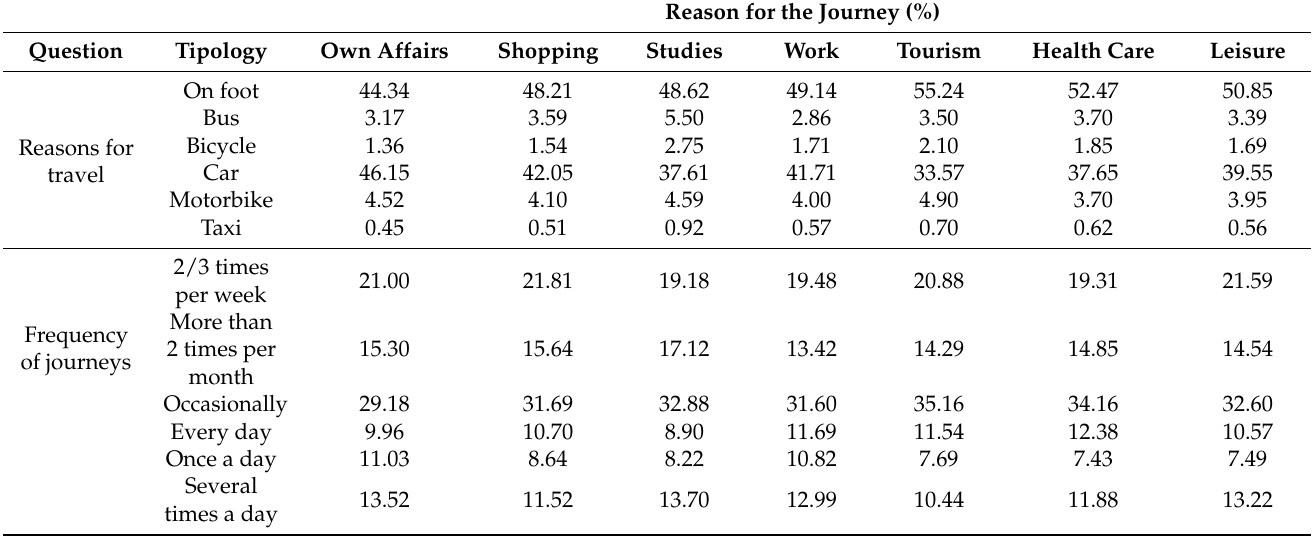
Table 3. Means of transport and frequency of travel by purpose. Reason for the Journey